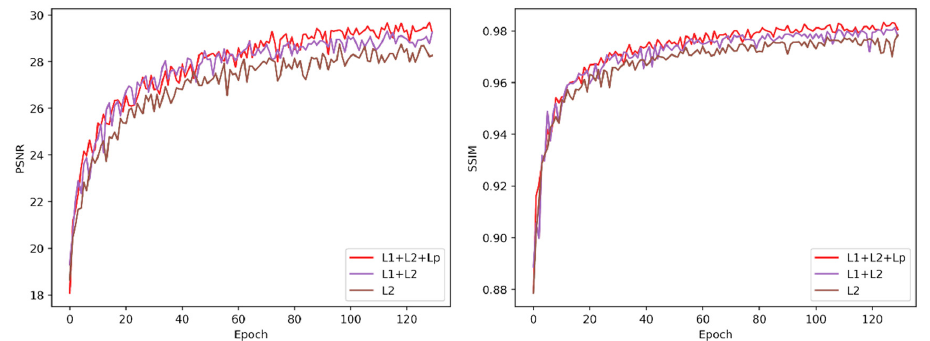
Figure 11. Left : PSNR variation curve of di ff erent loss functions. Right : SSIM variation curves of Figure 11. Left: PSNR variation curve of different loss functions. Right: SSIM variation curves of different loss functions. di ff erent loss